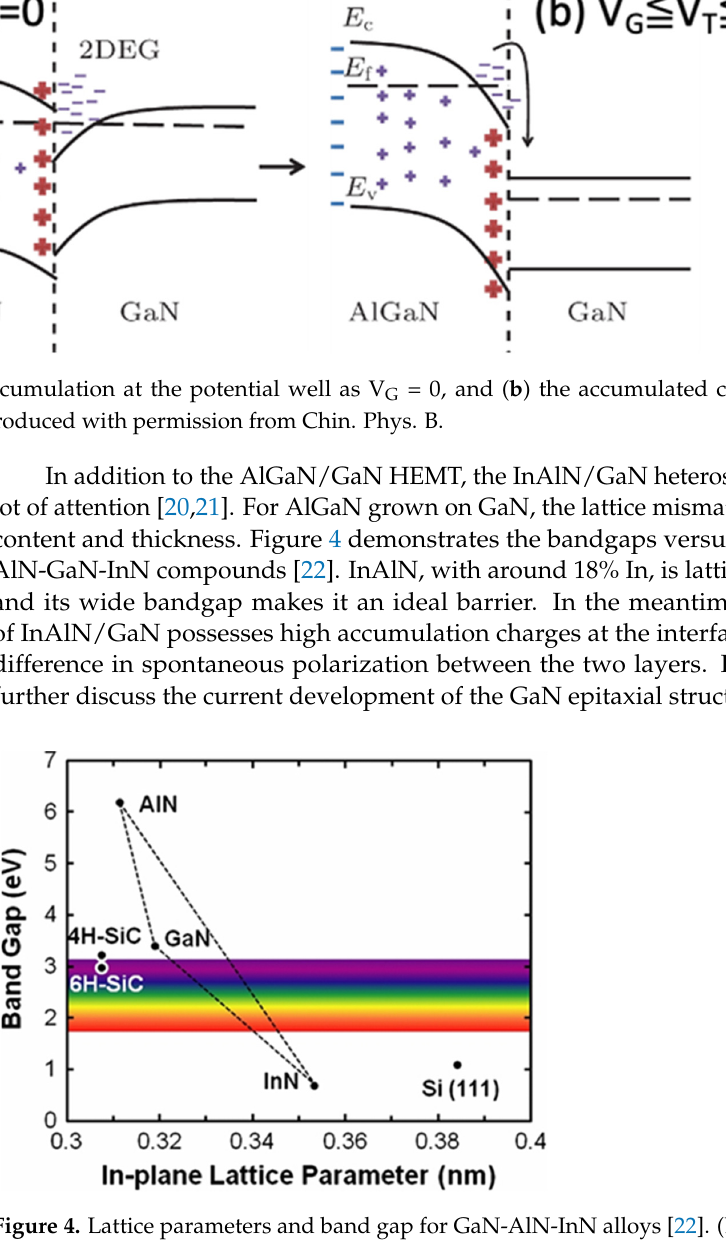
Figure 2. Gallium nitride wurtzite structure [18]. (Data from [18]).